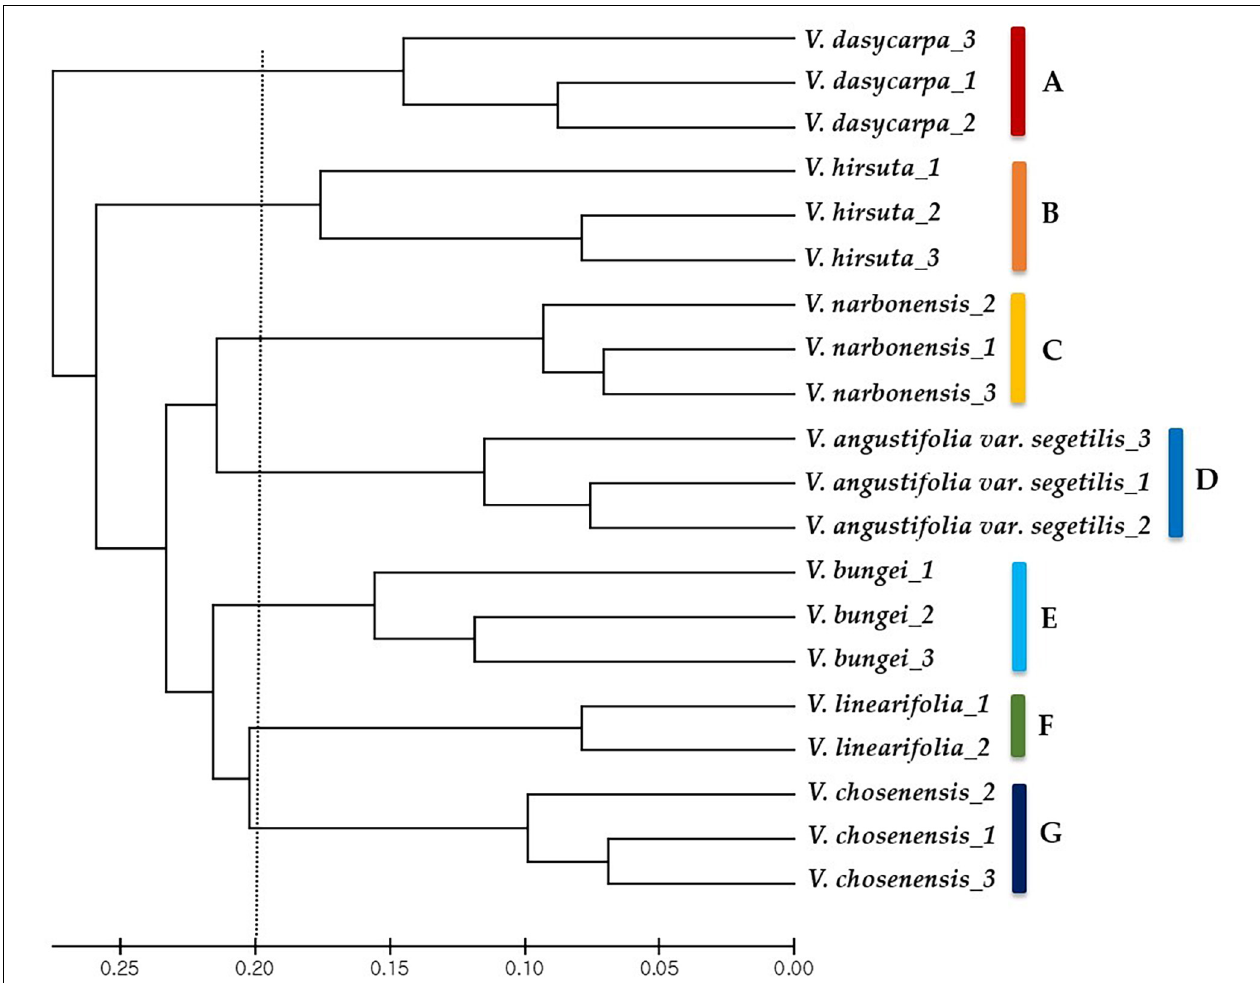
FIGURE 2 | Phylogenetic relationships between 20 Vicia spp. accessions. The phylogenetic tree was constructed with data from 39 chloroplast simple sequence repeat markers using the unweighted pair group method with arithmetic mean method. Letters A–E on the right-hand side represent each plastome group based on the plastome